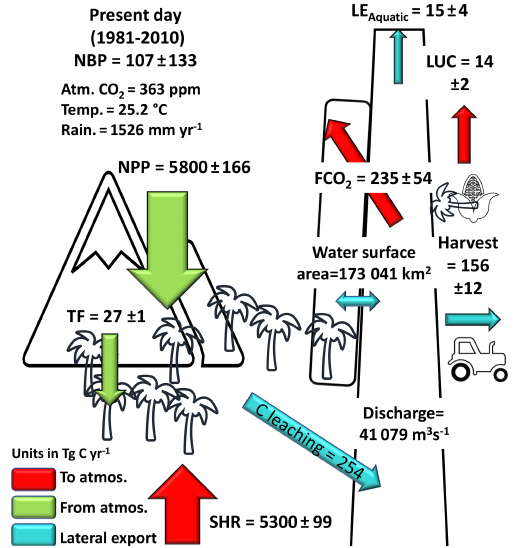
Figure 7. Annual C budget (NBP, net biome production) for the Congo Basin for the present day (1981–2010) simulated with ORCHILEAK; NPP is terrestrial net primary productivity, TF is throughfall, SHR is soil heterotrophic respiration, FCO 2 is aquatic CO 2 evasion, C leaching is C leakage to the land–ocean aquatic continuum (FCO 2 + LE Aquatic ), LUC is the flux from land use change, and LE Aquatic is the export C flux to the coast. Range rep- resents the standard deviation (SD) from